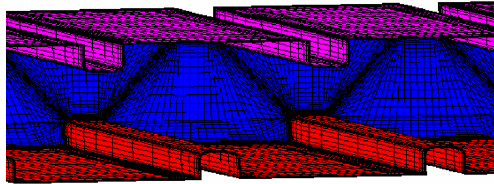
Figure 1: A representative mesh arrangement for a ribbed section of the channel.